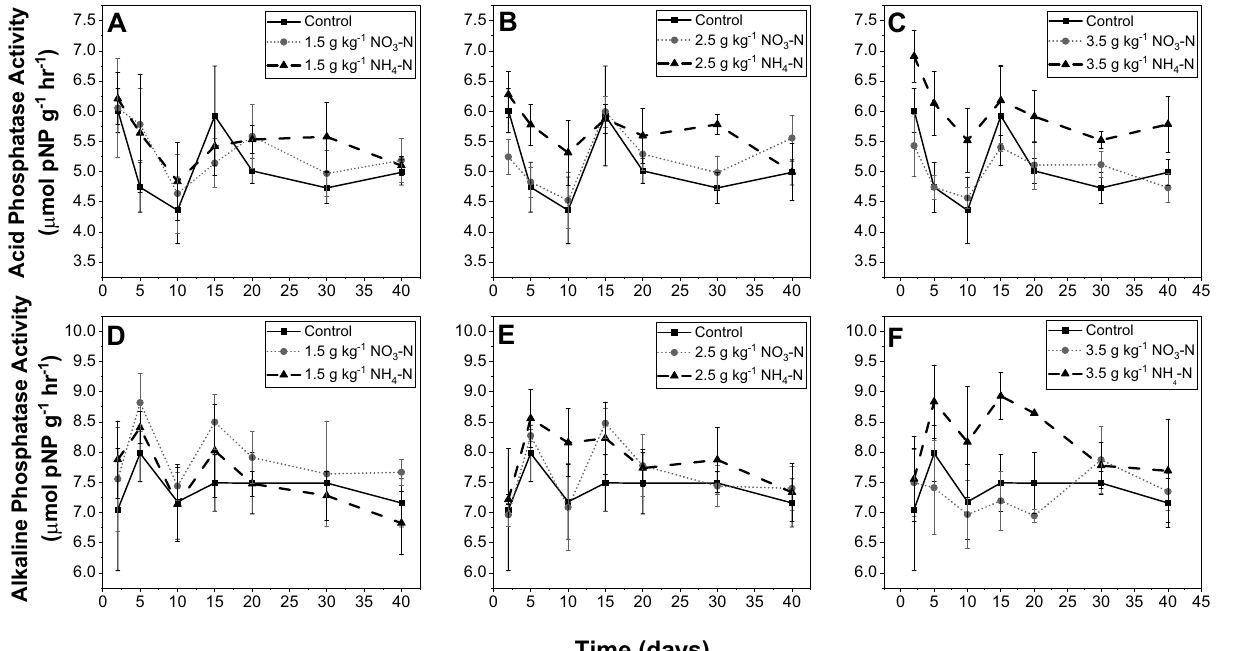
Figure 1. Acid phosphatase activity ( A – C ) and alkaline phosphatase activity ( D – F ) during a 40-day incubation as a function of nitrate or ammonium amendment 1.5–3.5 mg N kg −1 The error bars indicate the standard